Question: Write a single sentence explaining what this figure depicts.
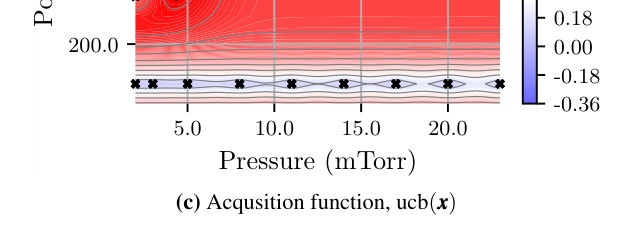
Answer: The figure shows the contour plots of exploitation term, µpos in Fig. 6a, exploration term β ·σpos in Fig. 6b, and UCB in Fig. 6c for the seventh iteration with β = 1. At this iteration, BayesOpt is exploring the region X2.